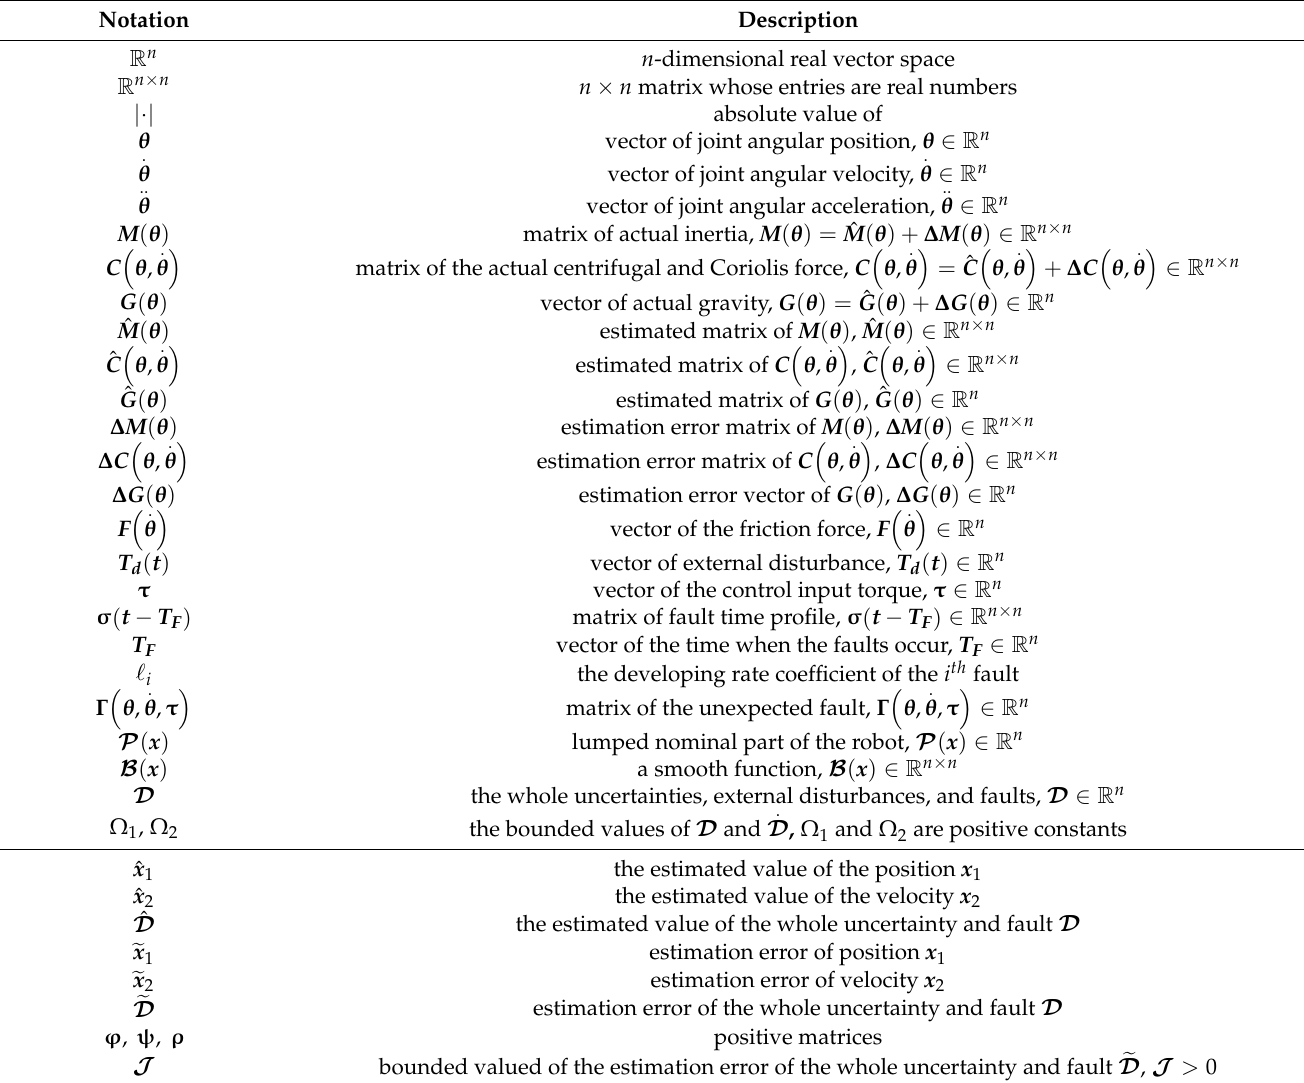
Table 1. List of